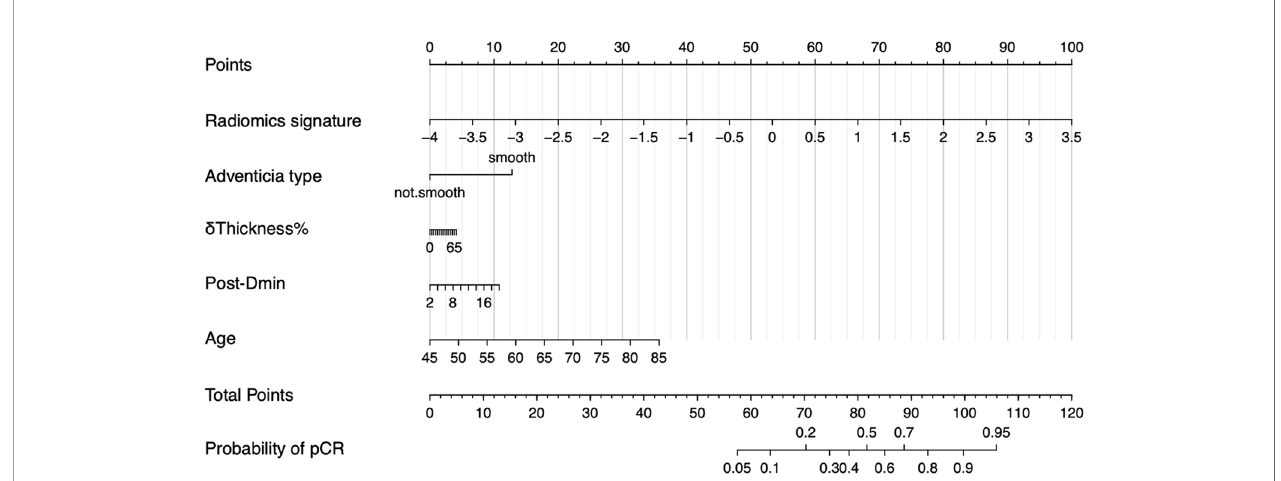
FIGURE 5 | Nomogram of RS+clinical model. The nomogram built based on radiomics signature and clinical variables provide an easy-to-use tool in clinical